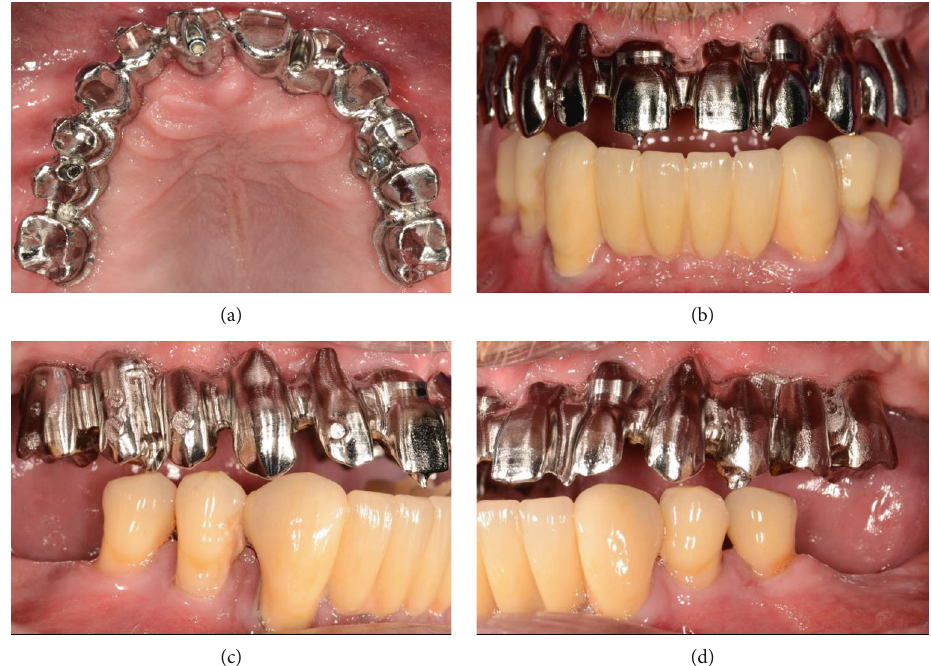
Figure 11: (a) Axial view of the CoCrMo framework. (b) Frontal view of the CoCrMo framework. (c) Right view of the CoCrMo framework. (d) Left view of the CoCrMo